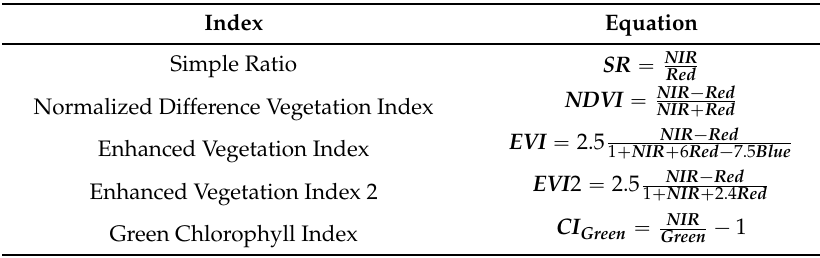
Table 1. Vegetation indices used in this research (NIR, Red, Green, and Blue corresponds to TM/ETM+ band 4, band 3, band2, and band 1